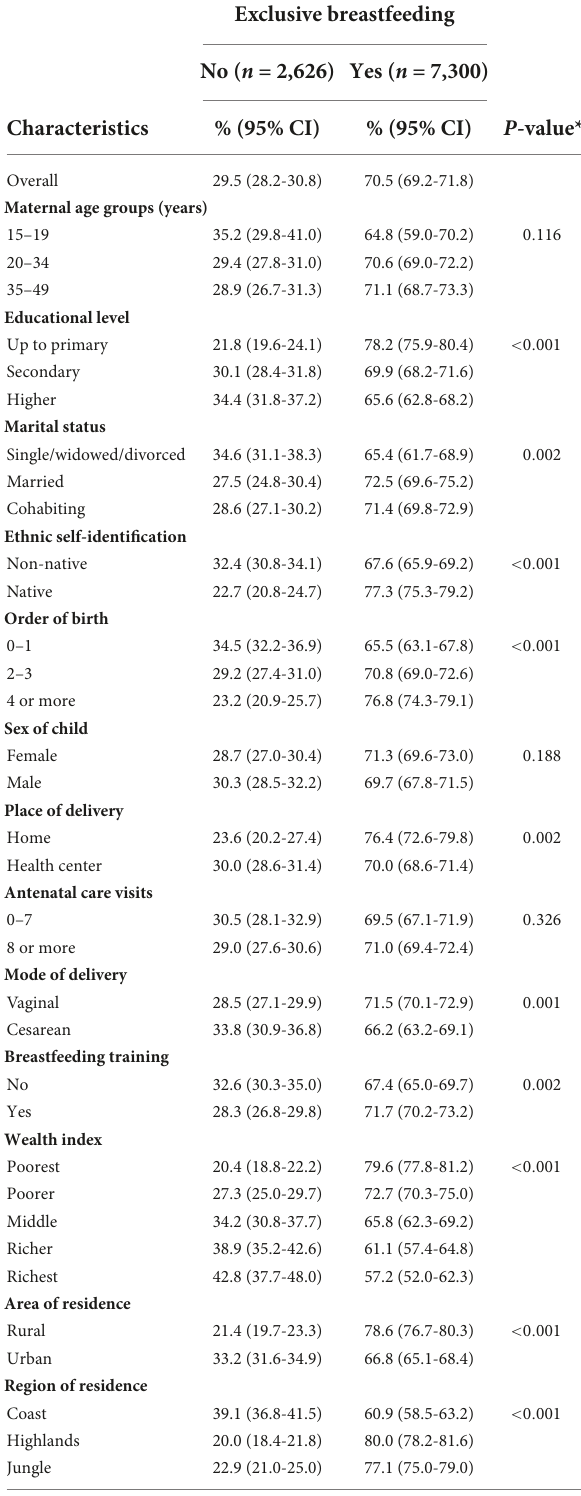
TABLE 2 Prevalence of exclusive breastfeeding (EBF) by characteristics of the Peruvian women aged 15–49 years and their children aged 6–59 months included in the